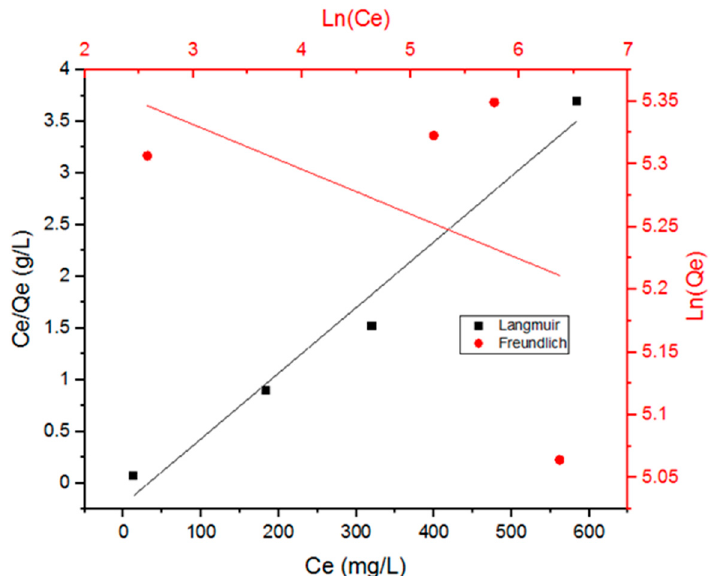
Figure 4. Data fitting with the Langmuir model and the Freundlich model for the adsorption of Doxycycline onto UiO-66. Table 1. Adsorption parameters for the Langmuir and Freundlich adsorption